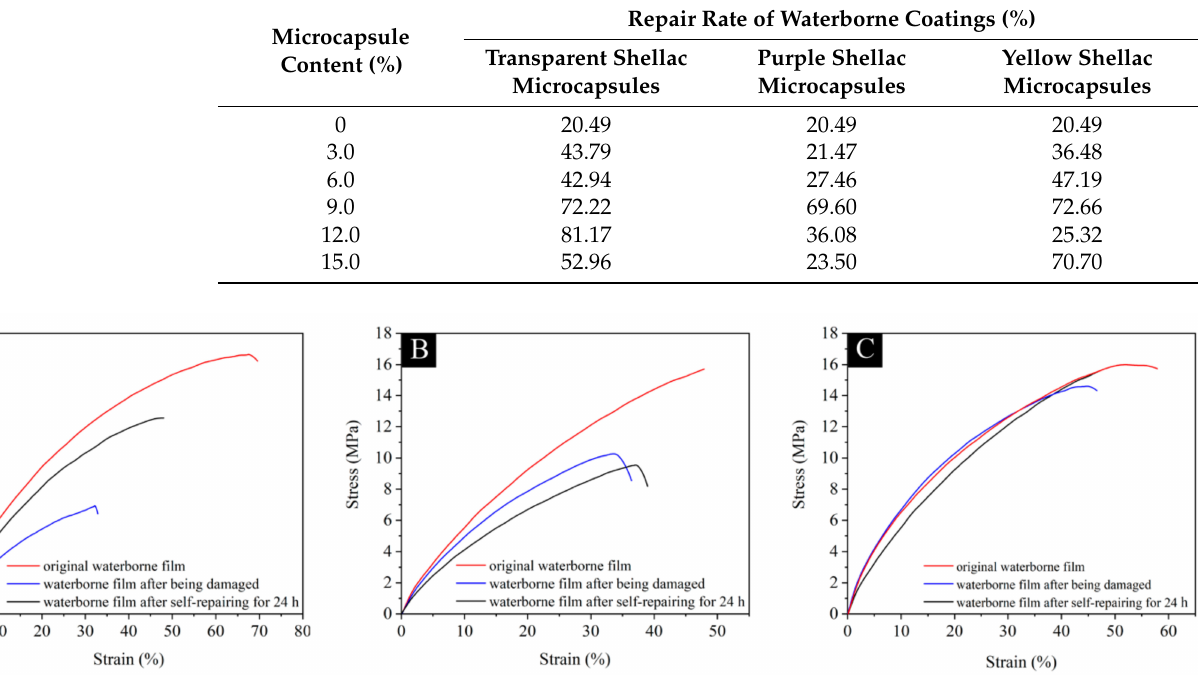
Figure 9. Stress–strain curves of the waterborne film with 3.0% microcapsule with different shellac: ( A ) transparent shellac microcapsules, ( B ) purple shellac microcapsules, ( C ) yellow shellac